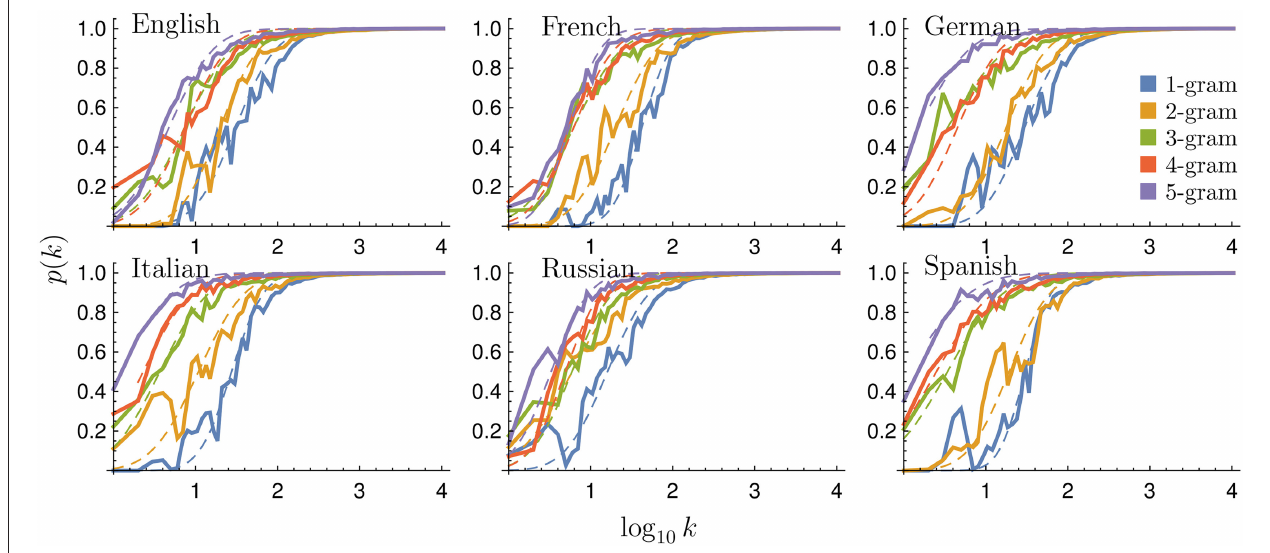
FIGURE 7 | Change probability for different languages and N -grams. Binned change probability p ( k ) as a function of rank k for all languages and N values considered (continuous lines). We also include fits according to the sigmoid in Equation (1) (dashed lines), as in Figure 2 .